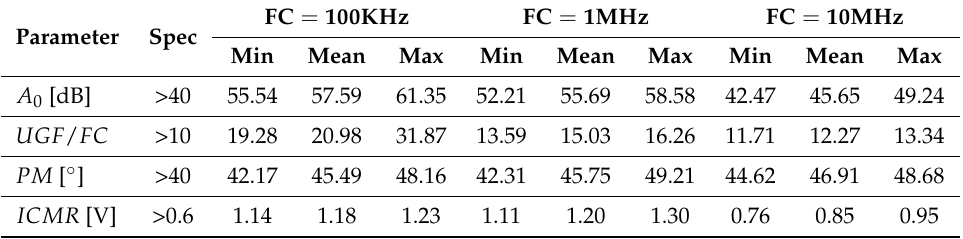
Table 3. Performance metrics of the Pareto front solutions obtained through SQP optimization of the 2nd-order active-RC low-pass filter optimization in a TSMC 180 nm process (Noise ( V N ) reported at 10